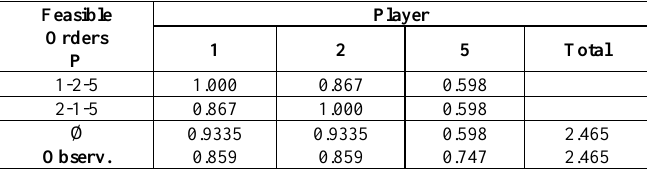
Table 11: Feasible orders for 21-brood game, good